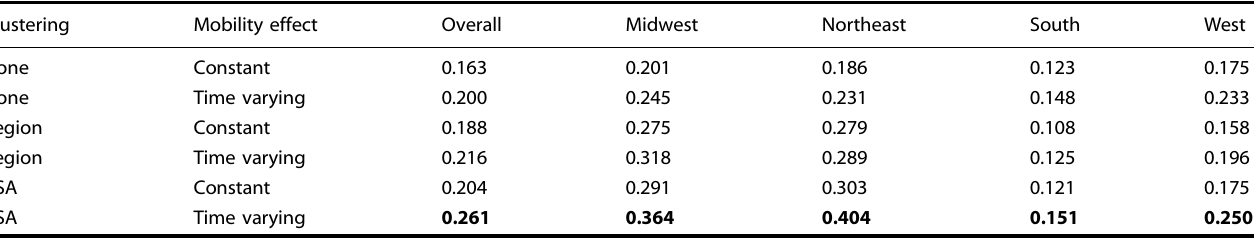
Final model R 2 are shown in